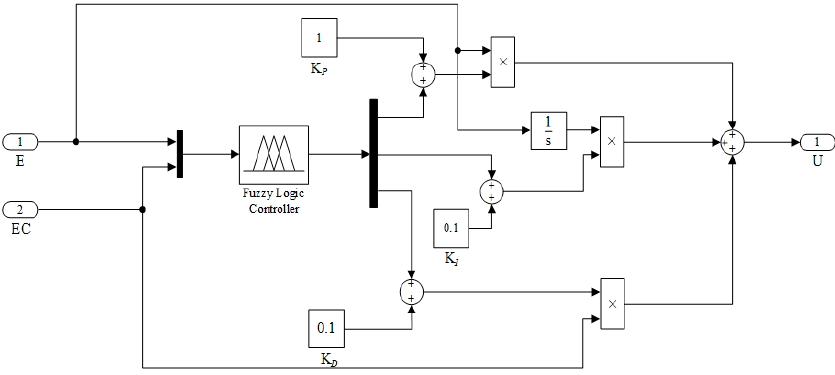
Figure 10. Simulation model of fuzzy PID controller.